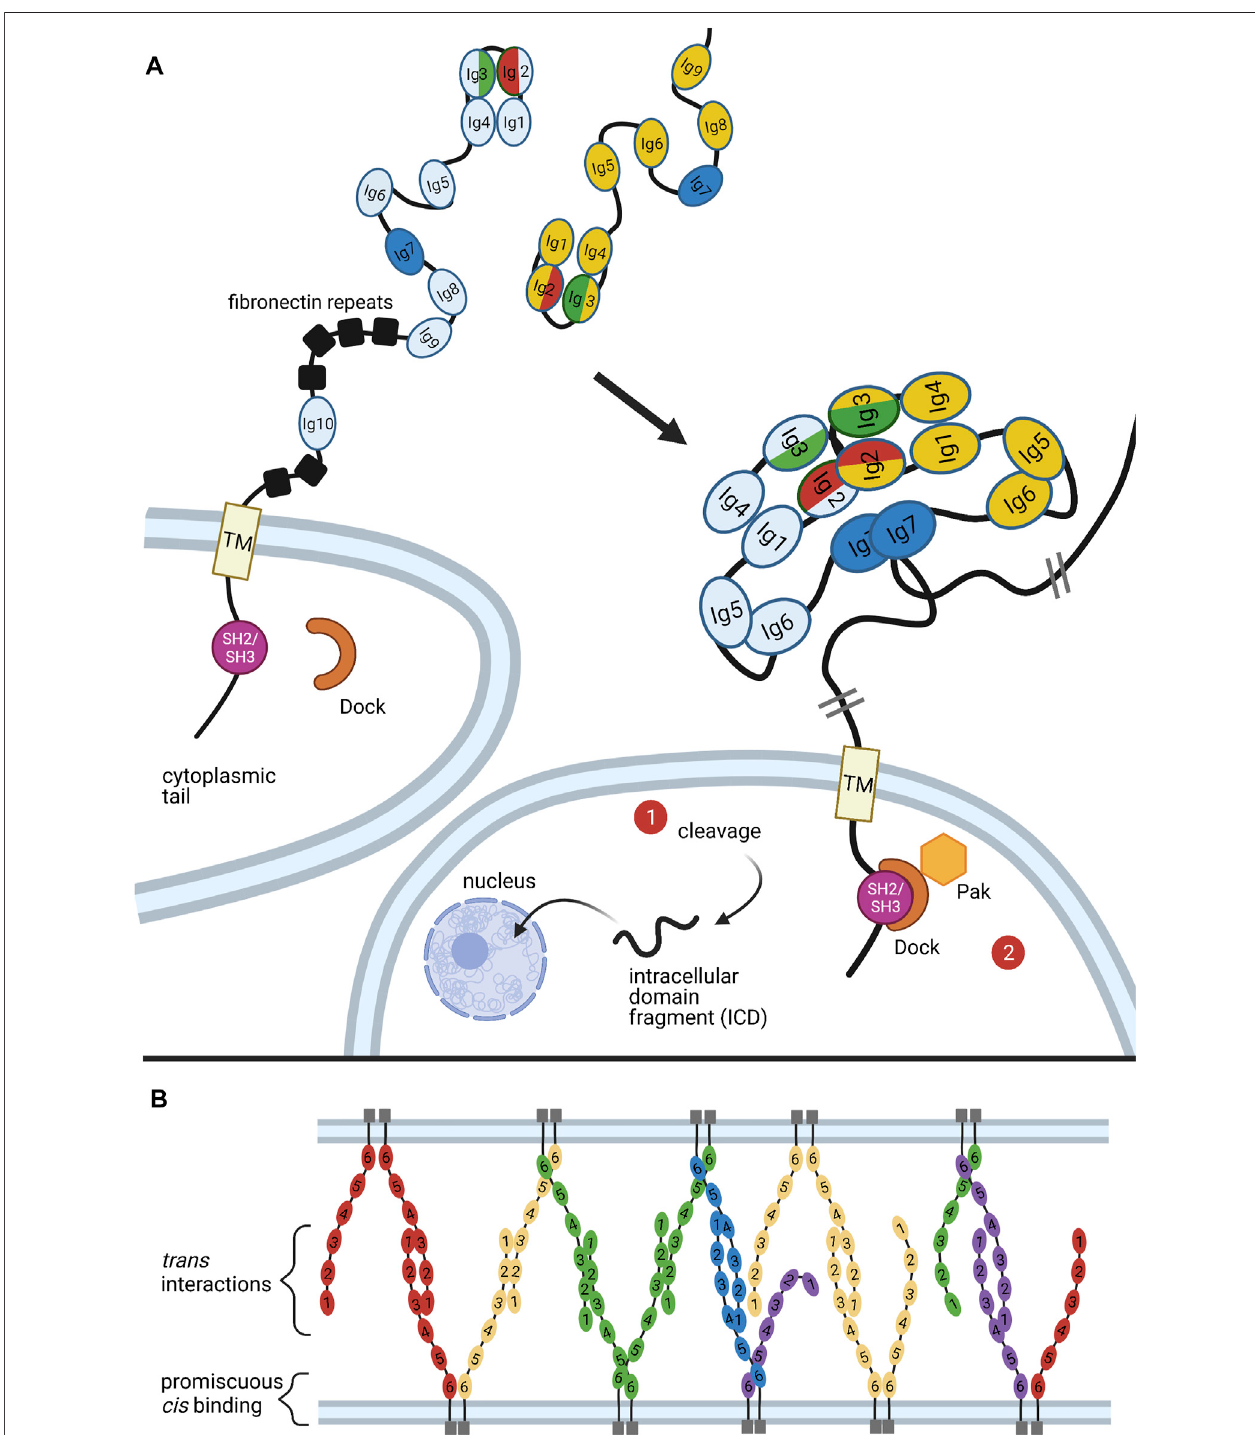
FIGURE5| BindingofDscamsandProtocadherins. (A) Homophilic bindingofDscamdomainsIg1-Ig8producesanS-shapeddimer (Meijers etal.,2007;Sawaya etal.,2008).ThevariantdomainsIg2,Ig3,andIg7conferbindingspeci fi city,withthevarianthalvesofIg2(red)andIg3(green)formingacompositebindinginterfaceand Ig7 (blue) binding independently (Sawaya et al., 2008). Upon homophilic binding, a repulsive signal is generated (Matthews et al., 2007). While it is still unclear what mediates this signal, two possible pathways are illustrated. First, studies in mammalian DSCAMs revealed anuclear localization signal (NLS) in the cytoplasmic tail. Upon cleavageofthetail, theNLSpromotestranslocationofthetailfragmentintothenucleus, whereitaffectsexpression ofsynapsinggenes.Althoughsimilarcleavage and nuclear translocation hasnot yet been demonstratedin fl ies, fl y Dscams do have aconserved NLS inthe cytoplasmictail (Sachse et al., 2019).Second, the adaptor